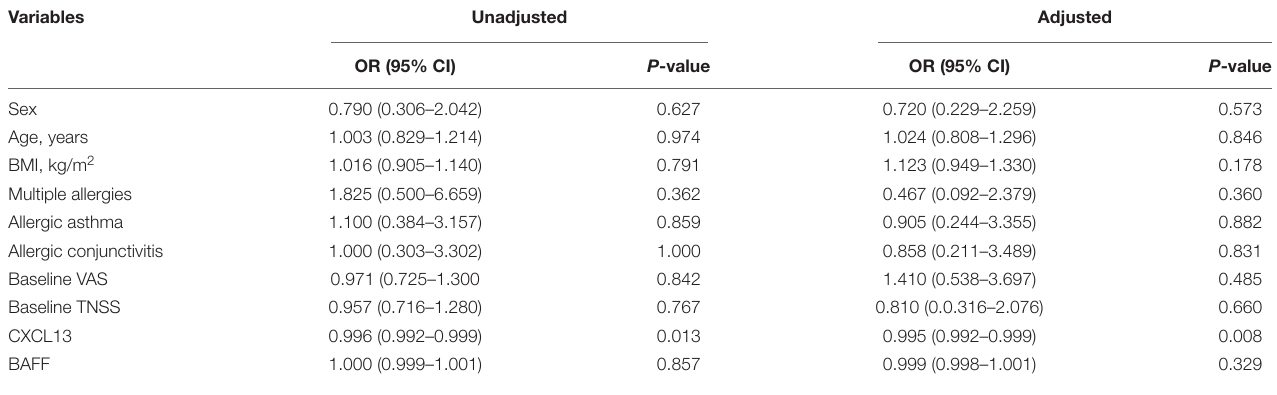
FIGURE 5 | The serum levels of (A) CXCL13 (B) BAFF between valid and invalid groups in the validation queue. The CXCL13 level is significantly increased in the effective group in comparison with the ineffective group ( P < 0.01). The BAFF level is no statistical difference between the two groups ( P > 0.05). CXCL13, C-X-C motif ligand 13; BAFF, B cell-activating factor. TABLE 5 | Binary logistic regression exploring factors associated with SCIT efficacy in validation